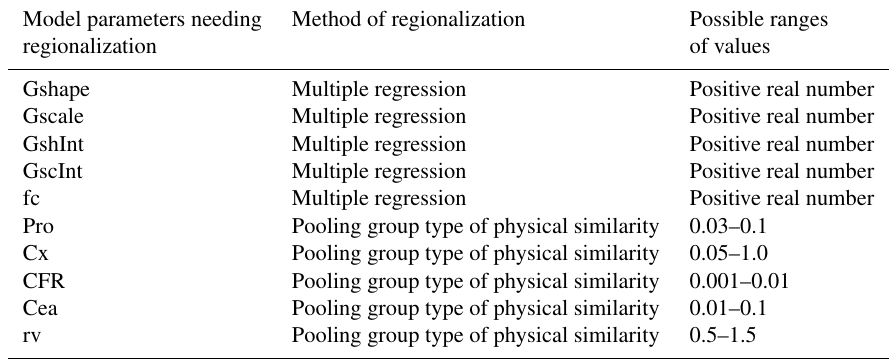
Table A4. Possible ranges of regionalized DDD model